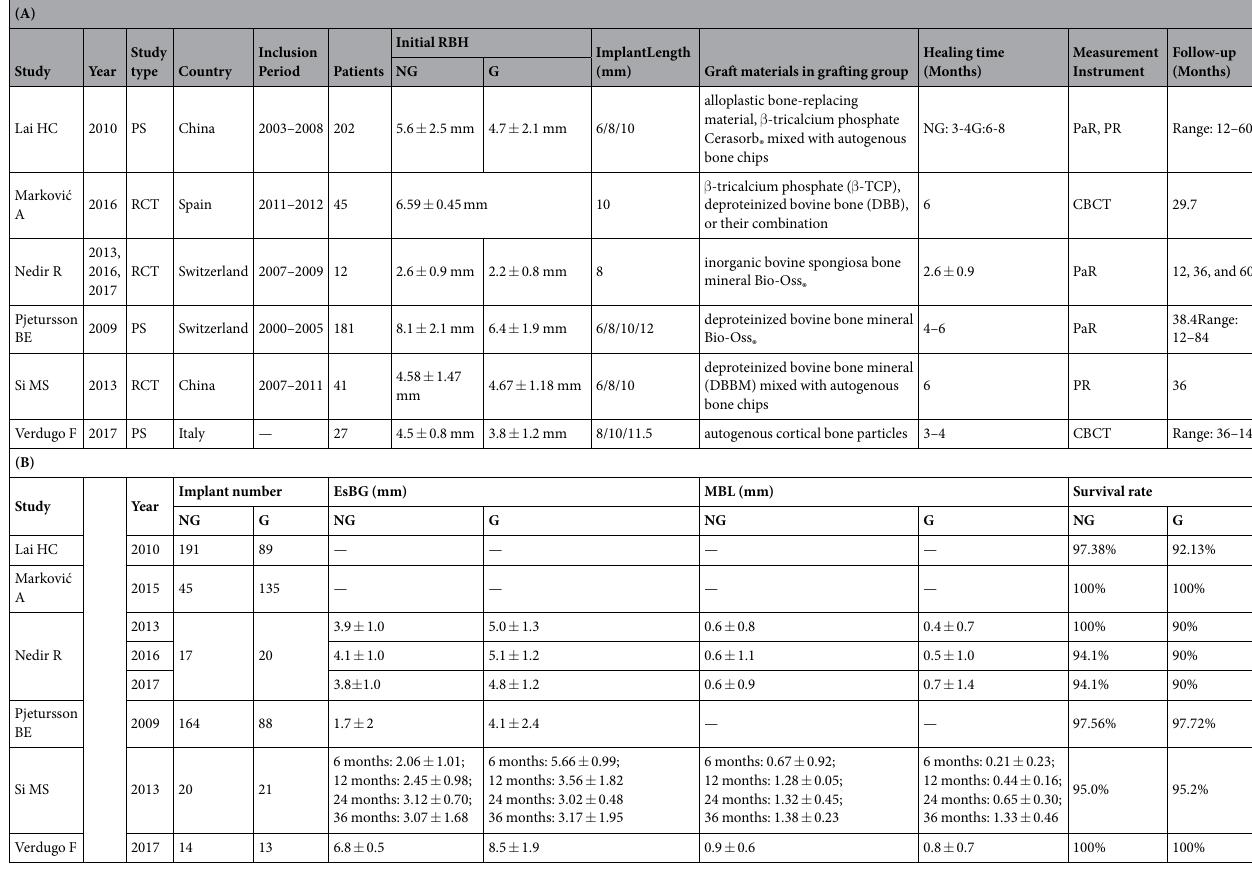
Table 2. (A) Characteristics of controlled studies. (B) Outcomes of controlled studies. PS, prospective study; NG, non-graft. group; G, graft group; PaR, periapical radiograph; PR, panoramic radiograph; CBCT, cone